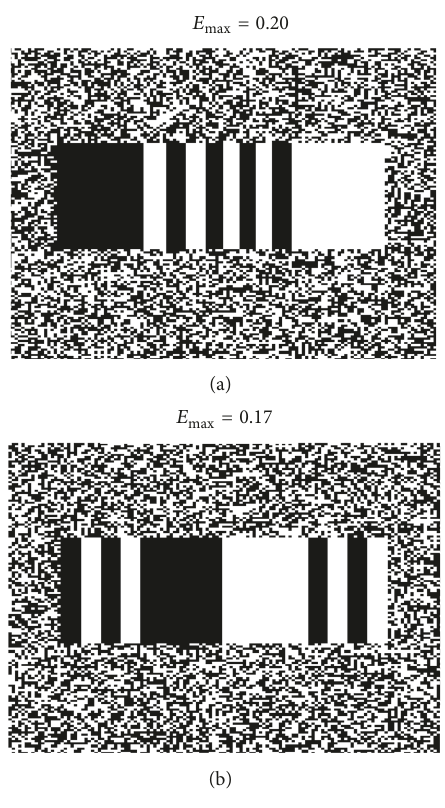
Figure 6: Scheme of two configurations mixing wide and narrow bands; the corresponding maximum repulsive energies are given on the top. To (a) wider bands are at the ends producing higher repulsive energy; to (b) wider bands are at the center slightly lowering the repulsive